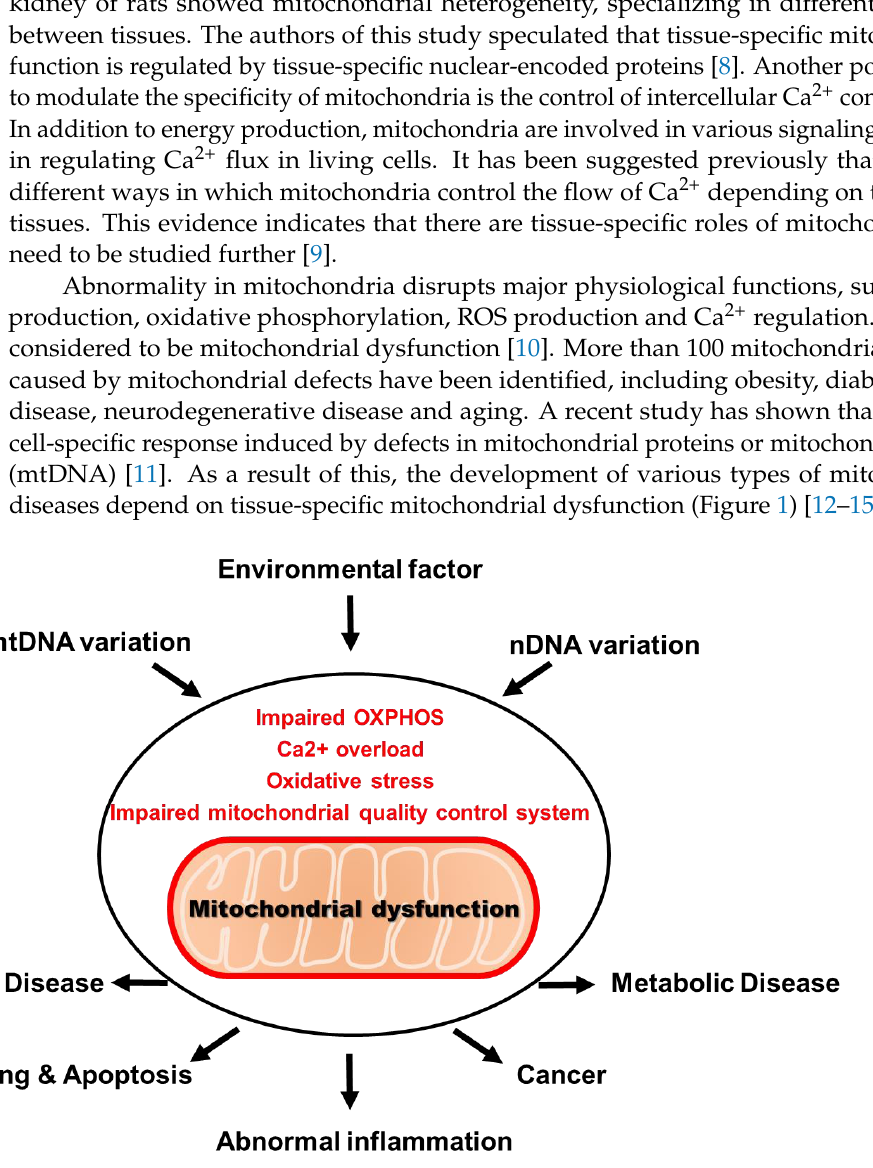
Figure 1. Mitochondrial dysfunction and disease.